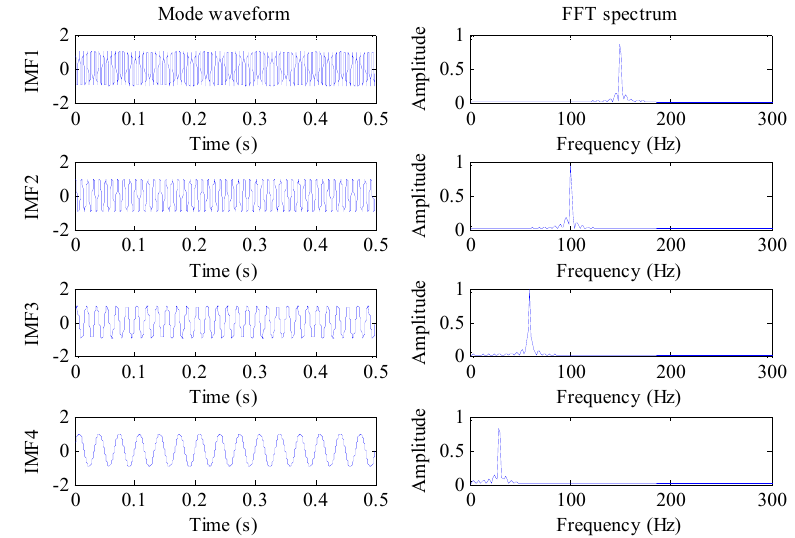
Figure 9. The decomposition results obtained by IAVMD for simulation 1 and their corresponding FFT spectrum.